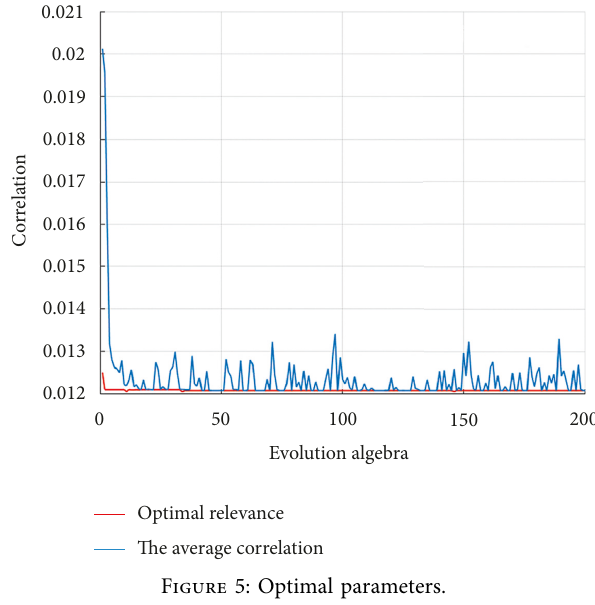
Figure 5: Optimal parameters.